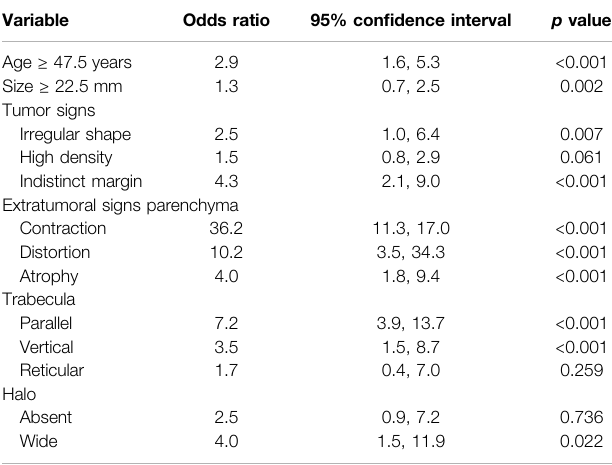
TABLE 3 | Multivariate logistic regression analysis of variables associated with malignant